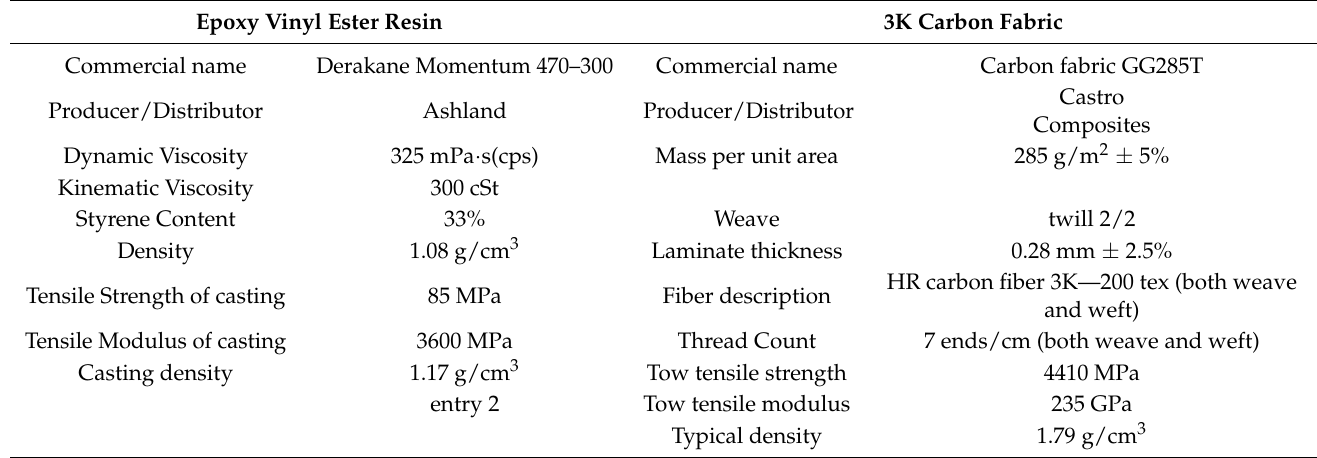
Table 1. Mechanical characteristics of CFRP components as stated by the manufacturers